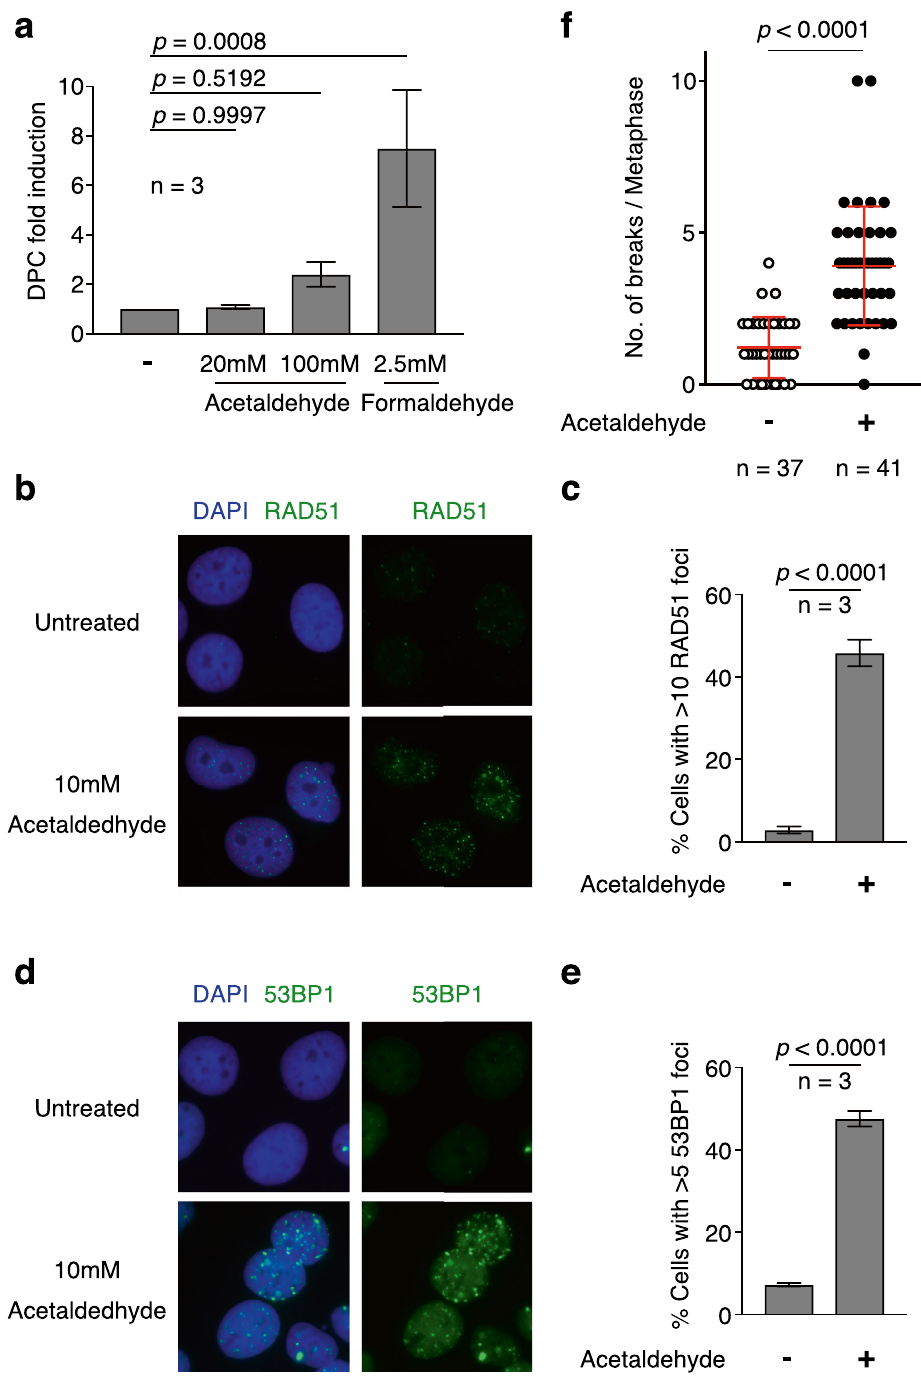
Figure 2. Acetaldehyde induces DNA double-strand breaks (DSBs). ( a ) Quantification of DNA–protein-cross links (DPCs) derived from U2OS cells treated with the indicated concentrations of acetaldehydes or formaldehyde. DPC amount was analysed using the ARK assay. The DPC-fold induction was calculated by normalising the amount of DPC in each sample to that of the untreated samples. Statistical significance was determined using an unpaired t test. Error bars indicate standard deviation (n = 3). ( b ) Representative image of RAD51 focus-positive U2OS cells with (10 mM acetaldehyde) or without (untreated) acetaldehyde. ( c ) Frequency of RAD51-positive cells with (+) and without (−) acetaldehyde treatment. More than 100 cells were counted for each condition. Statistical significance was determined using unpaired t test. Error bars indicate standard deviation (n = 3). ( d ) Representative image of 53BP1 focus-positive U2OS cells with (10 mM acetaldehyde) or without (untreated) acetaldehyde. ( e ) Frequency of 53BP1-positive cells with (+) and without (−) acetaldehyde treatment. More than 100 cells were counted for each condition. Statistical significance was determined using unpaired t test. Error bars indicate standard deviation (n = 3). ( f ) Distribution of the number of chromatid/chromosome breaks in metaphase- arrested HCT116 cells with (+) or without ( −) 10 mM acetaldehyde. More than 35 metaphase samples were analysed for each condition. Data are presented as the mean ± standard deviation. Statistical significance was determined using the Mann– Whitney U